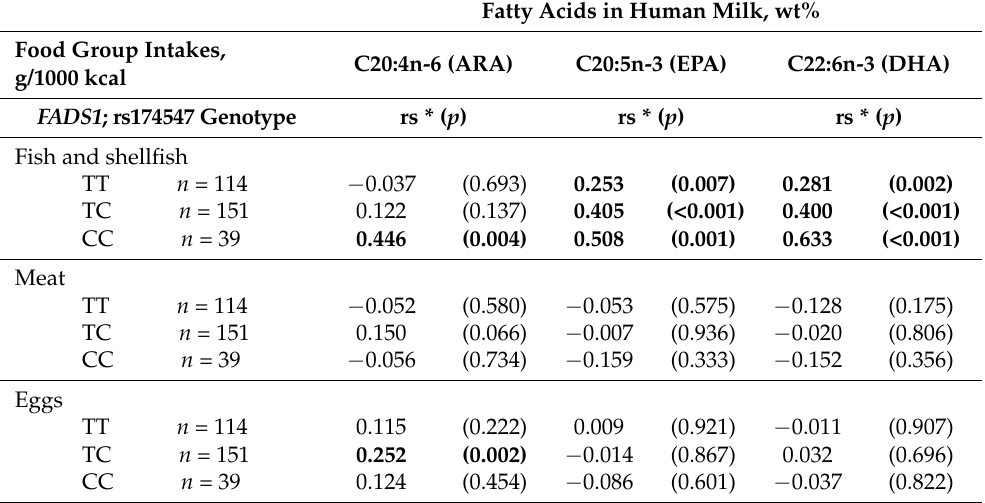
Table 3. Correlation between food group intakes in mothers and LCPUFA compositions in human milk by FADS1 rs174547